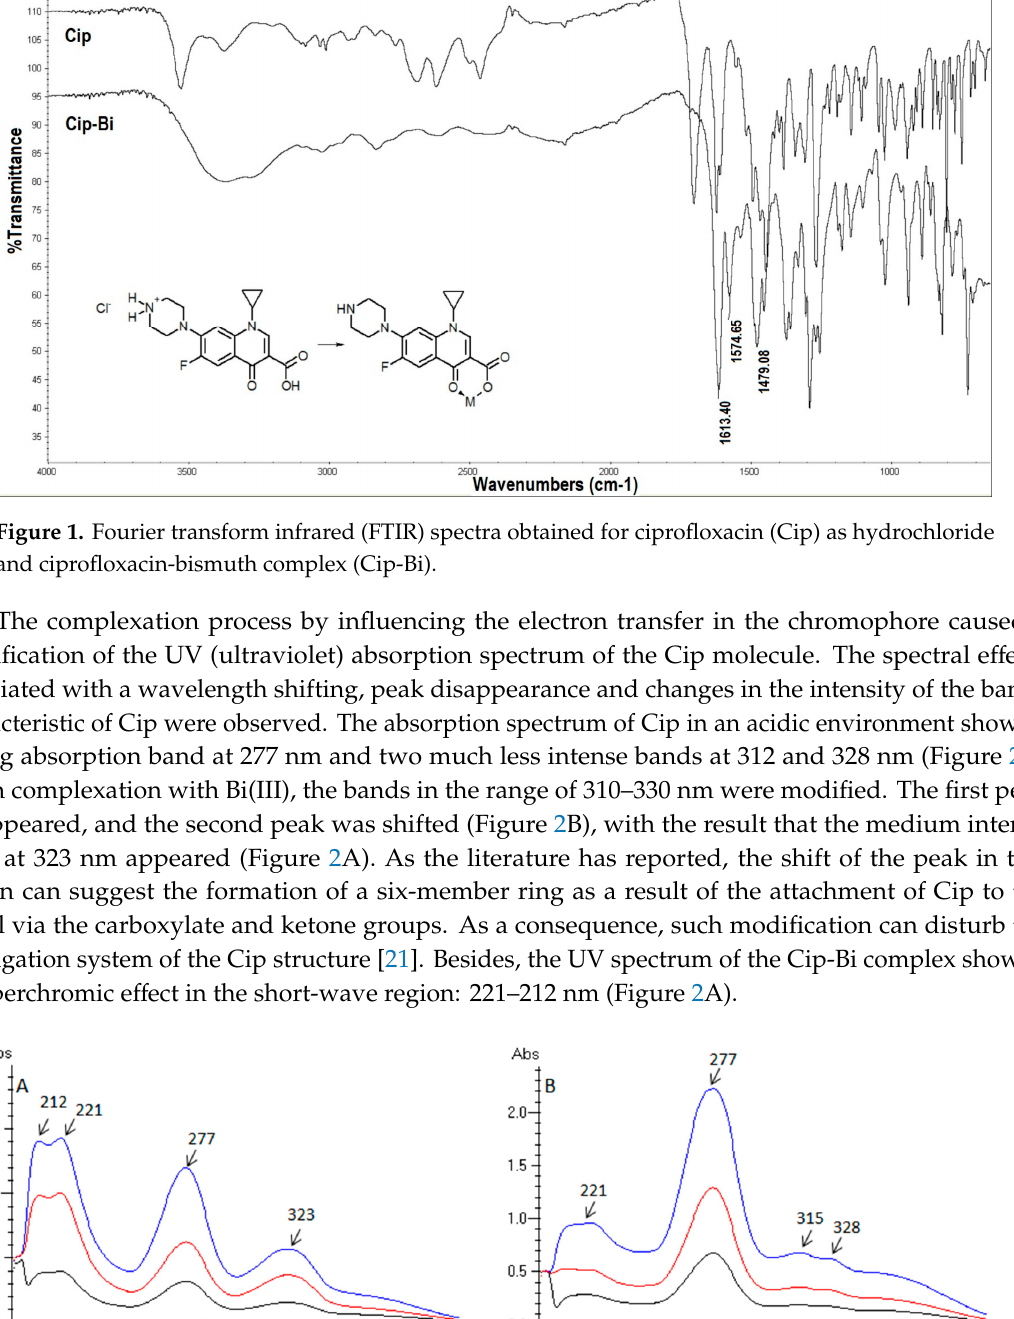
C Figure 3. Suggested three-dimensional (3D)-structure for ciprofloxacin-bismuth complex. The HPLC method was developed [22] for the quantitative assessment of Cip-Bi incorporated into the dressing matrix and released further on. UV-detection and FL (fluorescence)-detection (for control monitoring and recording low concentration levels) were used for the determination of Cip- Bi analyte and calibration curves. The calibration curve (Mandel’s linearity test: TV (tested value) = 1.65 − 2.32 < F99% (1.15) = 8.68, n = 18) was constructed by plotting the peak areas of Cip-Bi standard solutions versus the concentrations in the range of 3.0–18.0 μ g/mL with the correlation coefficient (R) greater than 0.9995. A typical linear regression equation for the calibration curve was y = 69,898 ±